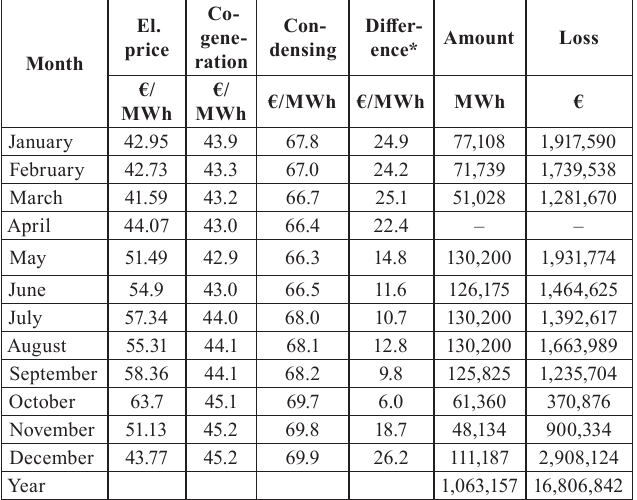
Comparison of Electricity Production Costs When Operating the CCGT in Co-generation and Condensed Modes (Kunickis et al. ,